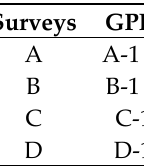
Figure 8. Ultrasonic measurements: ( a , b ) along traces A ‐ 121 and A ‐ 129 in the south aisle; ( c ) along edges of the trial pit; ( d ) along circular slabs. Table 1. Scheme of GPR and ultrasonic testing (UT)